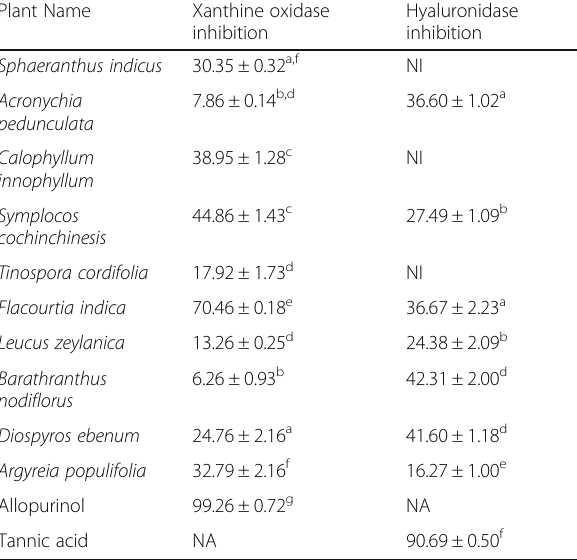
Table 3 Xanthine oxidase and hyaluronidase enzyme inhibitory activities of total ethanol extracts of medicinal plants